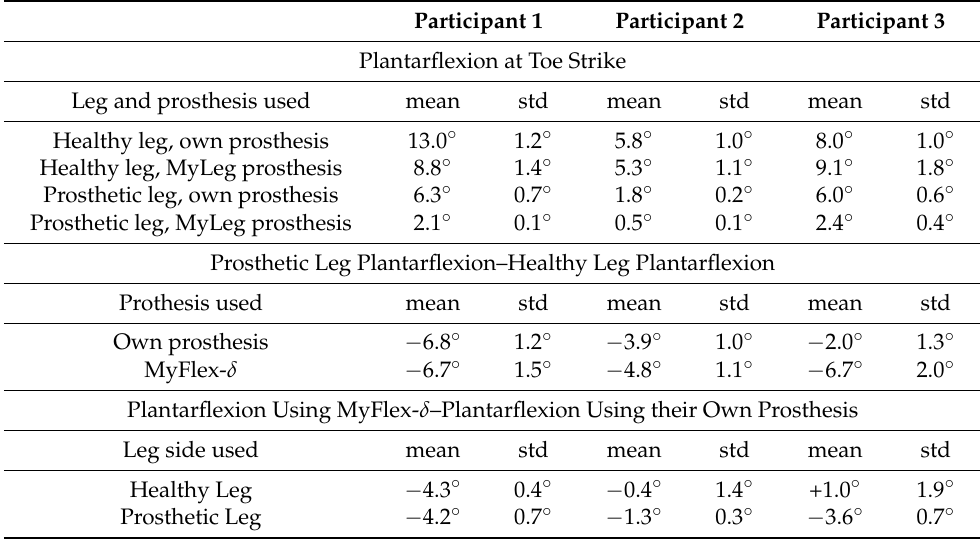
Figure 12. Procedures for the calculation of: ( a ) the difference between the rotation measured from the prosthetic leg and the healthy leg; ( b ) the difference between the rotation measured while using MyFlex- δ and while using their own prosthesis. Table 5. Plantarflexion at toe strike. Mean values (mean) and standard deviations (std) are calculated from 50 gait cycles.